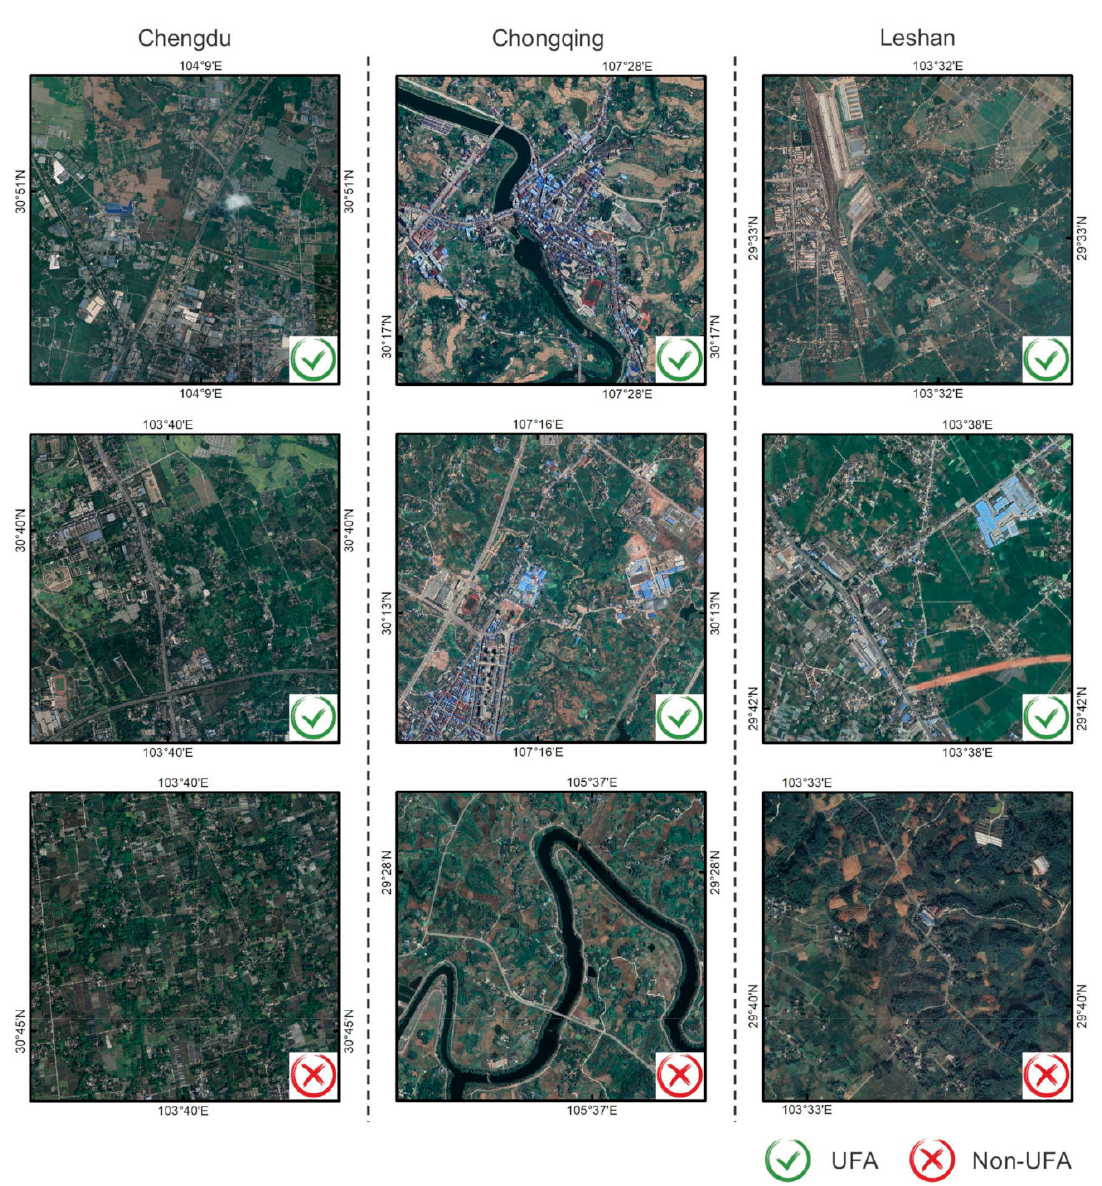
Figure A1. Remote sensing images of some sampling points in Chengdu, Chongqing, and Leshan. The coordinate reference system is the WGS-84 coordinate